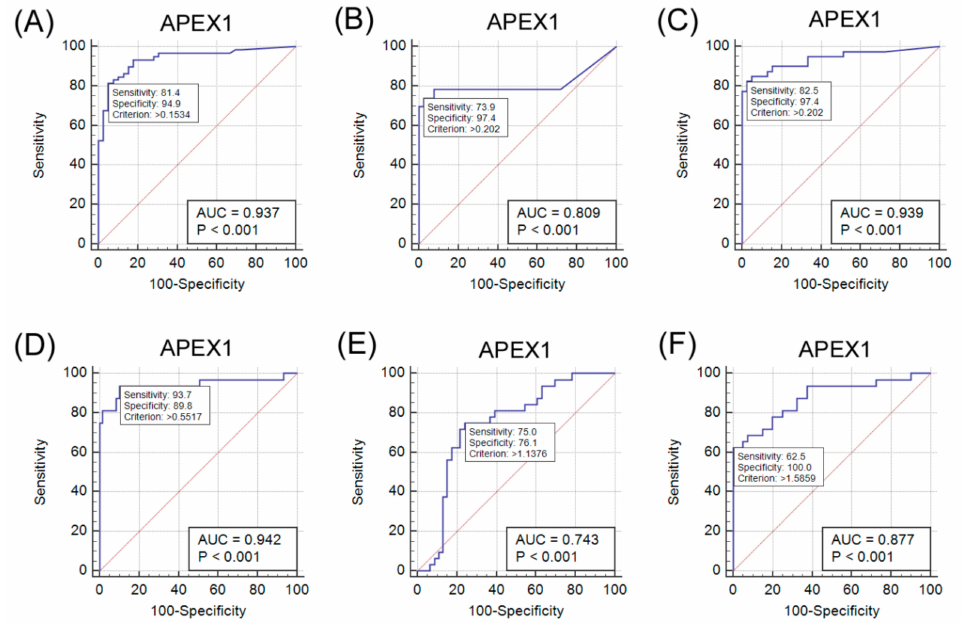
Figure 4. Analysis of the diagnostic value of serum APEX1 for hepatocellular carcinoma (HCC), cholangiocarcinoma (CC), and clear cell renal cell carcinoma (ccRCC) by receiver operating characteristic (ROC) curves. ( A – C ) ROC curves for the serum APEX1 levels to separate the HCC, CC, or ccRCC group from the healthy control. ( D – F ) ROC curves for the serum APE1 / Red-1 levels to separate HBV DNA ( + ) from the HCC, CC, or ccRCC group. ( A ) ROC curve: HCC ( + ) vs. healthy control group ( − ), 95% confidence interval: 0.869–0.976. ( B ) ROC curve: CC ( + ) vs. healthy control group (–), 95% confidence interval: 0.709–0.886. ( C ) ROC curve: ccRCC ( + ) vs. healthy control group (–), 95% confidence interval: 0.862–0.981. ( D ) ROC curve: HBV DNA ( + ) ( + ) vs. HCC (–), 95% confidence interval: 0.873–0.980. ( E ) ROC curve: HBV DNA ( + ) ( + ) vs. CC (–), 95% confidence interval: 0.631–0.835. ( F ) ROC curve: HBV DNA ( + ) ( + ) vs. ccRCC (–), 95% confidence interval: